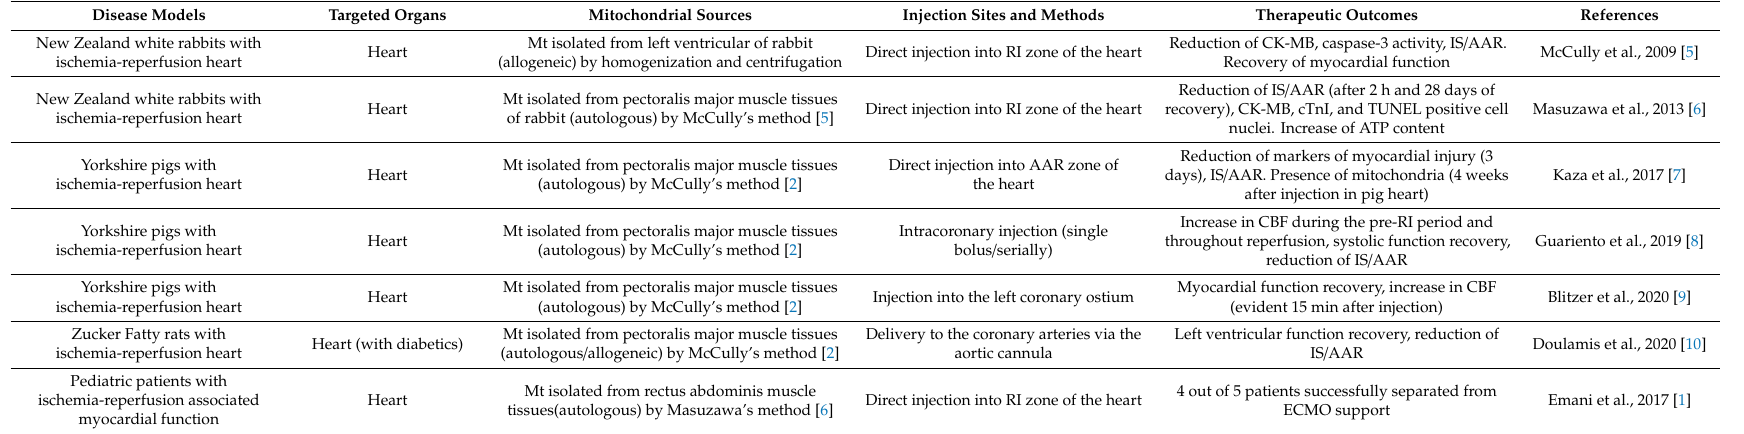
Table 1. Research reports of mitochondrial transplantation in the heart.